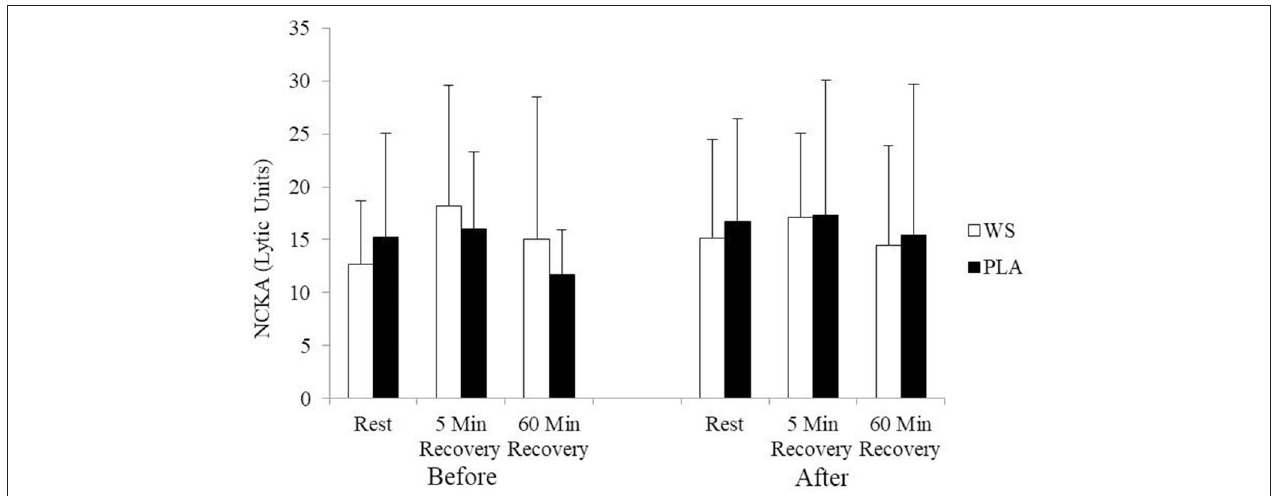
FIGURE 4 | Natural killer cell activity (NKCA) at rest, 5 and 60min after exercise before and after training for the whey supplement (WS) and placebo (PLA) groups. Lytic units, effector cells × 10 3 to lyse 30% of target cells. Values are means ±